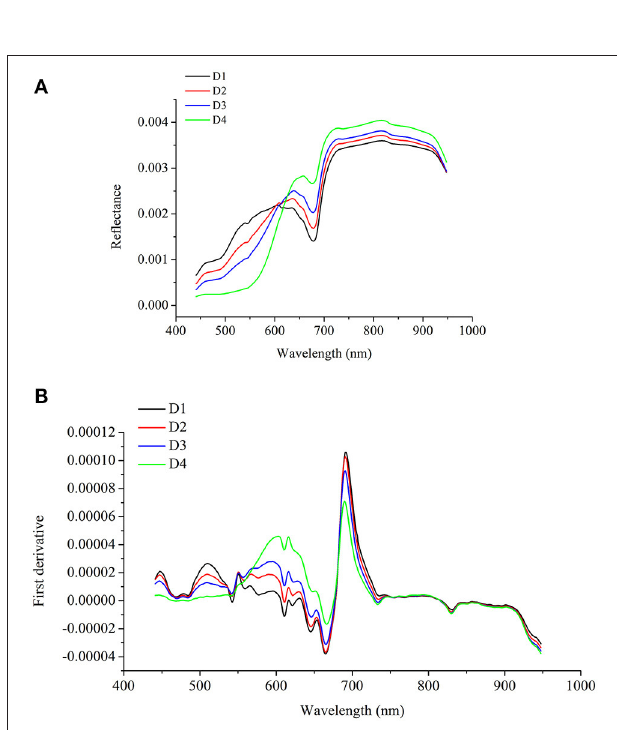
FIGURE 4 | Average spectra of strawberries from different maturity degree (A) and corresponding first derivative spectra (B)